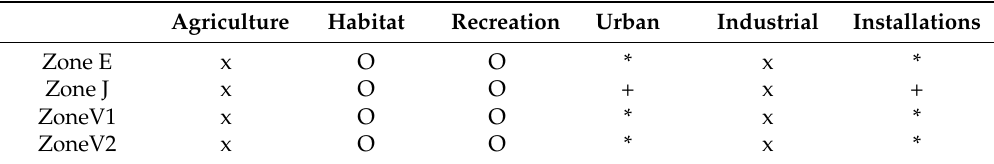
Table 2. Matrix of compatibility of uses of the soil: x—uses prohibited by parameters of the general arrangement; O—compatible; *—less compatible; +—compatible in some cases. Agriculture Habitat Recreation Urban Industrial Installations Zone E x O O * x * Zone J x O O + x + ZoneV1 x O O * x * ZoneV2 x O O * x